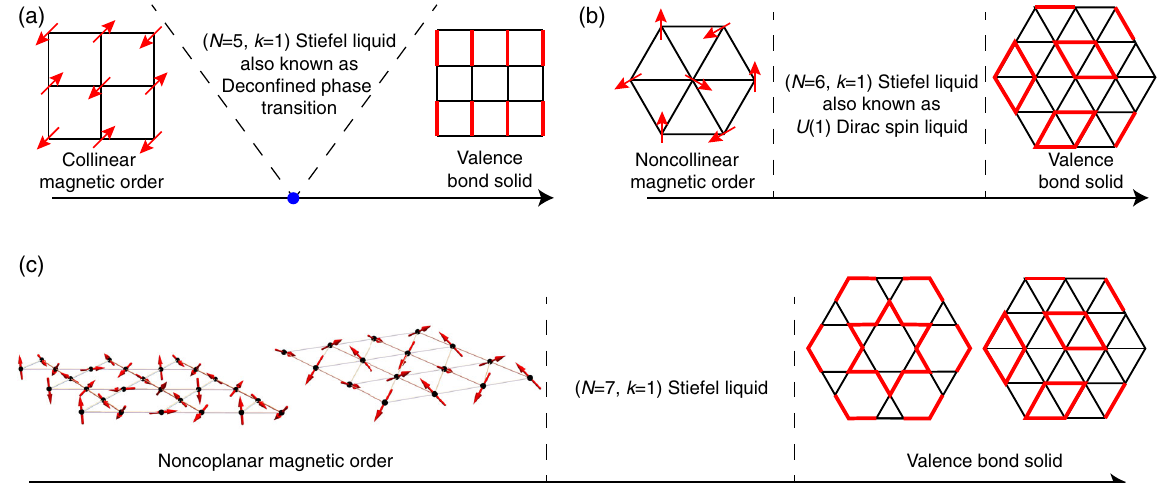
FIG. 1. The Stiefel liquid out of intertwined orders in quantum magnets. (a) ð N ¼ 5 ; k ¼ 1 Þ SL is the widely studied deconfined phase transition, which can arise from the intertwinement of collinear magnetic order (e.g., N´eel state) and valence bond solid. (b) ð N ¼ 6 ; k ¼ 1 Þ SL is the widely studied U ð 1 Þ Dirac spin liquid, which can arise from the intertwinement of noncollinear magnetic order (but coplanar) and valence bond solid. (c) ð N ¼ 7 ; k ¼ 1 Þ SL is a new critical quantum liquid, which can arise from the intertwinement of noncoplanar magnetic order and valence bond solid. On triangular lattice the noncoplanar order is known as the tetrahedral order. On kagome lattice the noncoplanar order is known as the cuboctahedral order, in which the magnetizations on the three − Q π Þ − Q π (cid:2) , S Q 3 cos ð n π Þ − Q 2 cos ð m π Þ , S Q 2 cos ð m π Þ þ Q 1 cos ½ð m þ n Þ π (cid:2) , with sublattices are S 3 cos ð n 1 cos ½ð m þ n Þ A ¼ B ¼ C ¼ Q 1 being orthogonal to each ; 2 ; 3